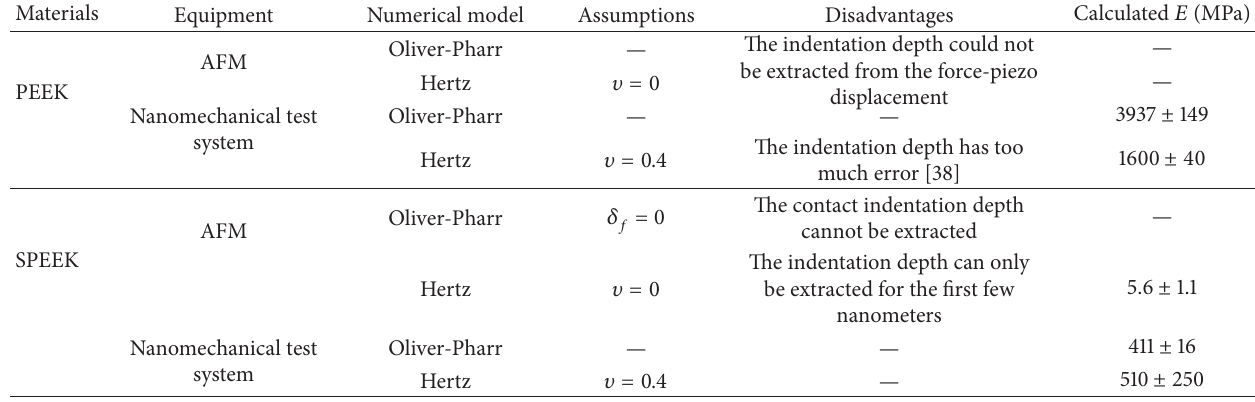
Table 2: Summary of the calculated elastic modulus and the disadvantages of each type of equipment and numerical model used in this study.